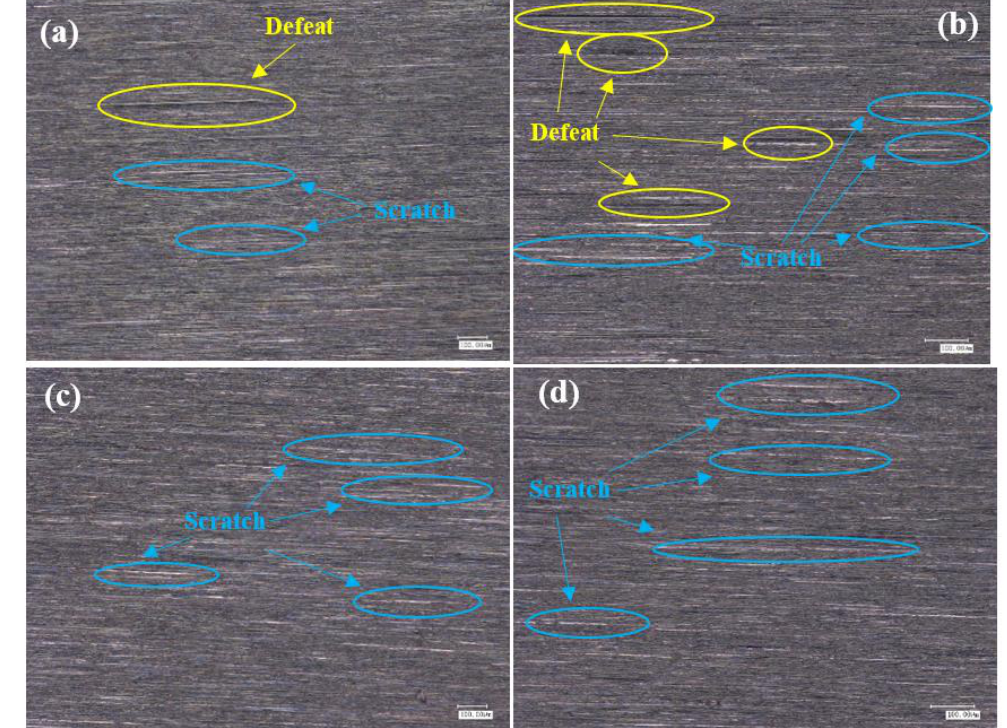
Figure 12. ( a , b ) Shows the surface of test 1, and ( c , d ) shows the surface of test 2.